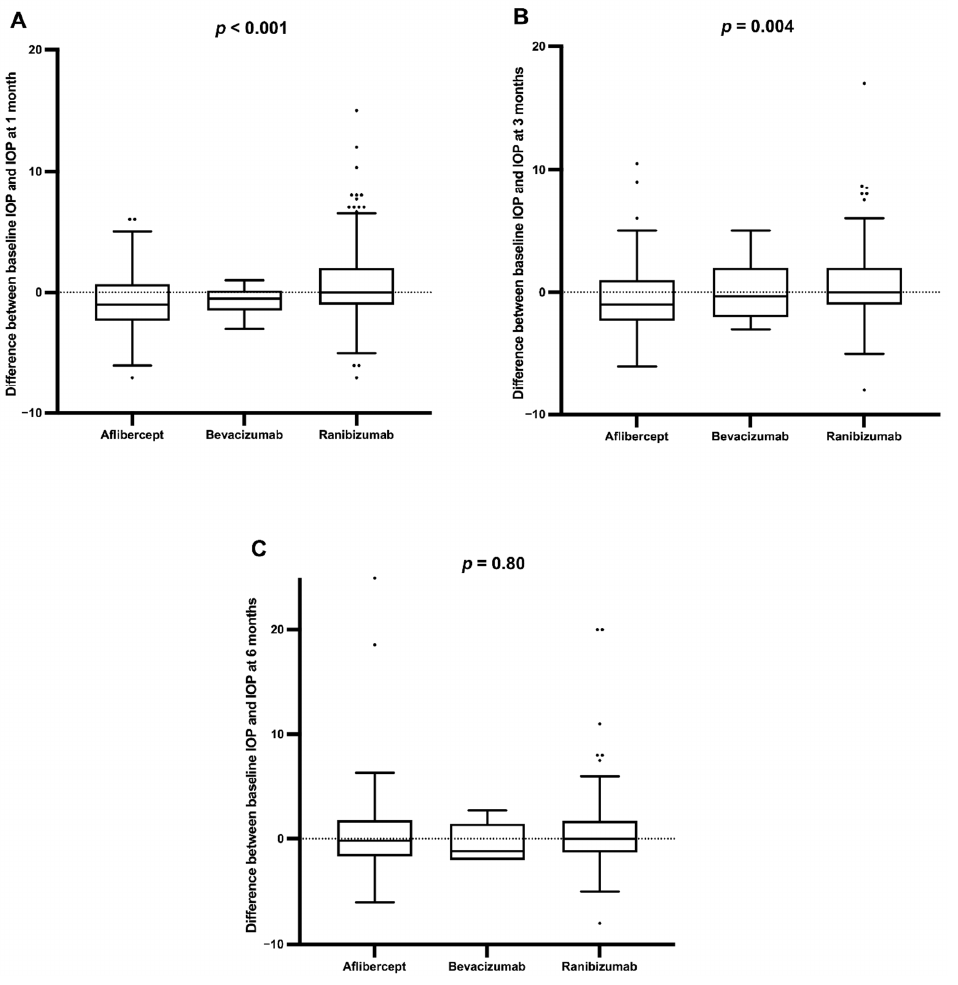
Figure 2. Variation between baseline intraocular pressure and intraocular pressure at 1, 3, or 6 months ( A – C , respectively) depending on anti-VEGF agent used in treated eyes.